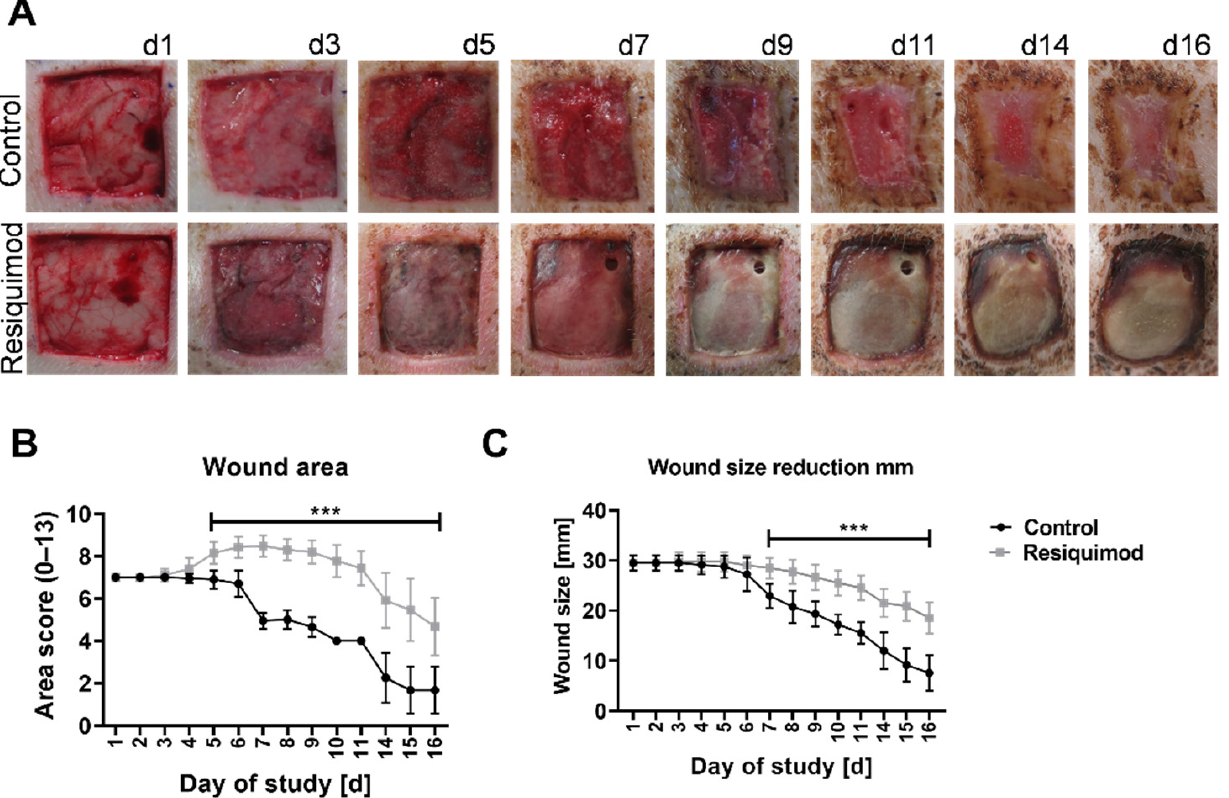
Figure 2. Wound morphology and wound area over the course of the experiment. Wounds of 3 × 3 cm were inflicted on the backs of pigs. Resiquimod was applied for 6 days, and the wounds were further examined over the course of 10 days. ( A ) Daily visual documentation and scoring was done. The control wounds (( A )–top row) showed physiological wound healing as well as wound contracture. The resiquimod-induced wounds (( A )–bottom row) showed a delay in wound healing and the formation of necrotic scabs. ( B ) The area scores showed higher values in resiquimod-induced wounds. ( C ) The wound size was determined by measuring the width of the wound, and less wound size reduction was shown in resiquimod-induced wounds. Data are presented as mean (dot) ± SD (whiskers) (n = 20 for control wounds; n = 40 for resiquimod-induced wounds). Data shown as mean ± SD. Statistical significance has been determined by 2-way ANOVA and corrected for multiple comparisons using the Sidak method. *** ( p < 0.001).